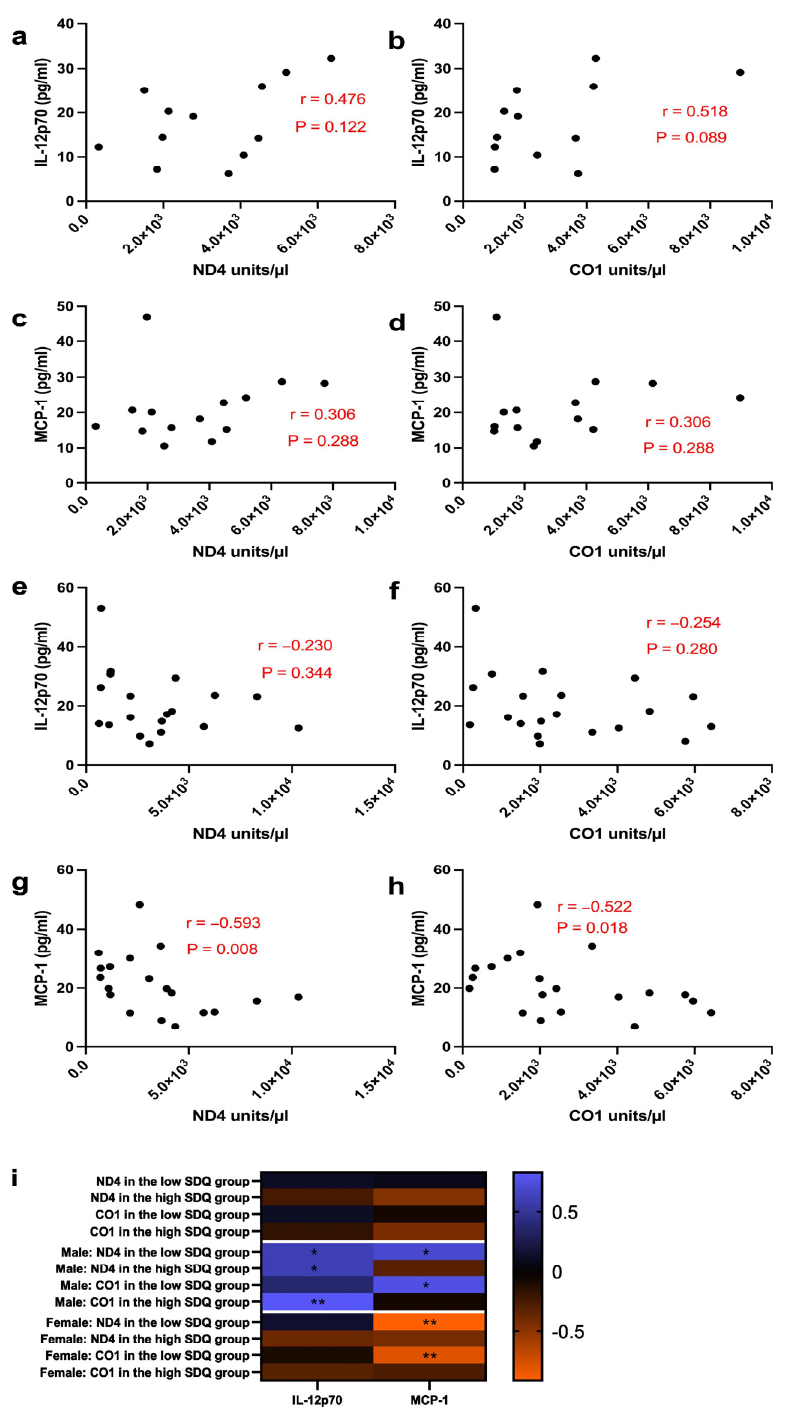
Figure 4. Correlation analysis of cytokine levels and ccf ‐ mtDNA units. ( a – d ) Correlation analysis of plasma IL ‐ 12p70 and MCP ‐ 1 levels with those of ND4 and CO1 units in males. ( e – h ) Correlation analysis of plasma IL ‐ 12p70 and MCP ‐ 1 levels with those of ND4 and CO1 units in females. ( i ) Clustering heatmap analysis for correlation of the cytokines IL ‐ 12p70 and MCP ‐ 1 and the genes ND4 and CO1 units in all the samples, and separated by sex. (* High correlation 0.6 < |r| ≤ 0.8, ** very high correlation 0.8 < |r| ≤ 1.0.)